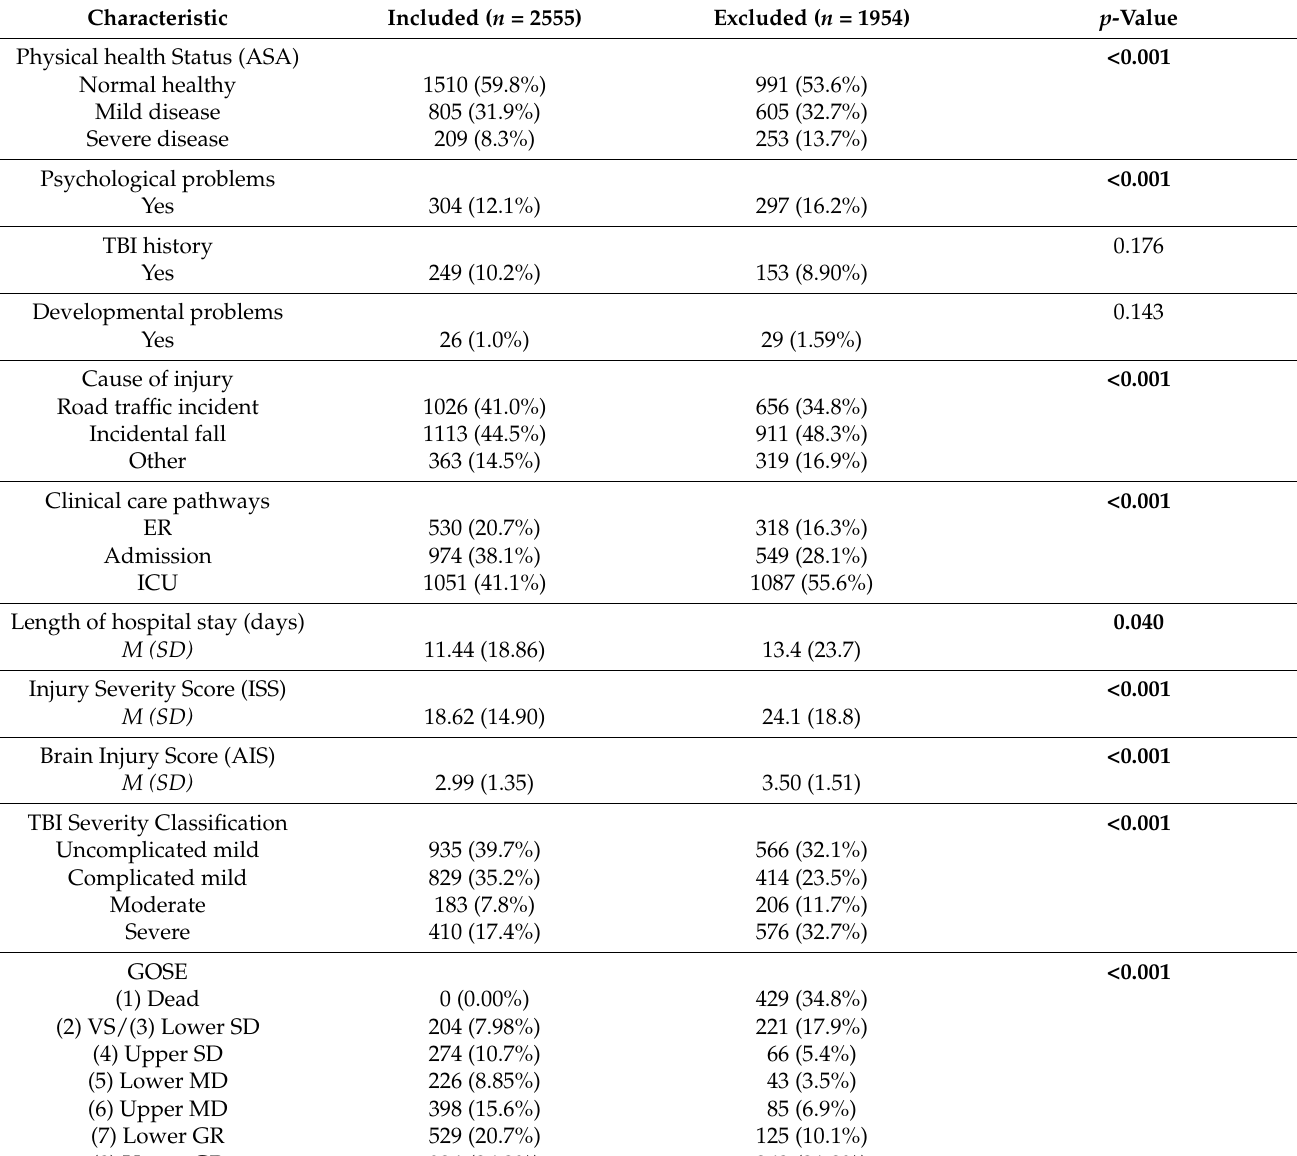
Table A2. Descriptive injury-related statistics for included and excluded